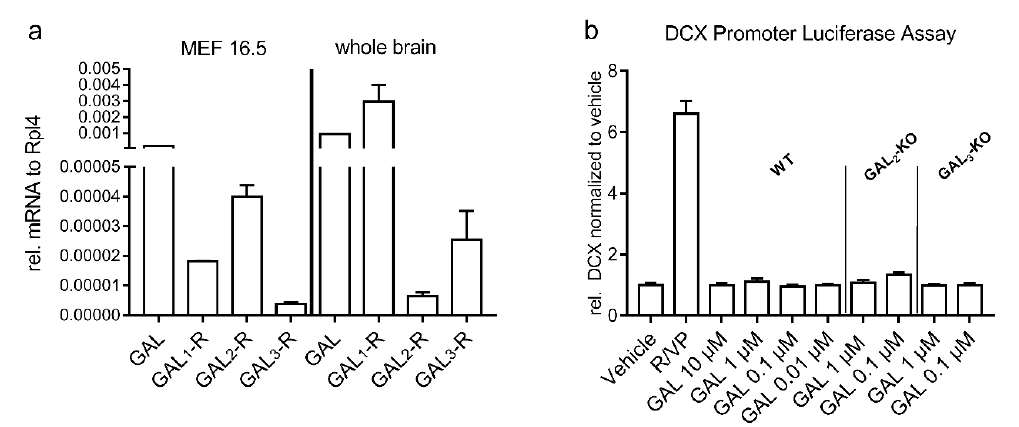
Figure 5. Gene expression analysis of the GAL-system. ( a ) Depicted are 2 − ∆ ct values from GAL and GAL 1–3 -R mRNA normalized to Rpl4 mRNA of mouse embryonic forebrain (MEF) cells from day 16.5 prenatal and C57BL/6N WT whole mouse brain. ( b ) Luciferase reporter activity driven by the DCX promoter in transfected primary MEF cells from day 16.5 prenatal. Cells were treated once with the peptides 3 days prior to the measurement. DCX Promoter experiments were performed at least in triplicates in 3 independent experiments, gene expression analysis was performed in duplicates and one representative experiment is shown. Values are represented as mean ± SEM. GAL, galanin; GAL 1 -R, galanin receptor 1; V/R, valproic/retinoic acid (positive control).